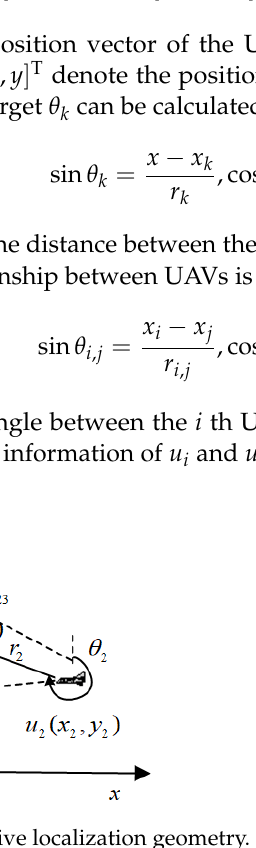
Figure 1. UAV swarm passive localization